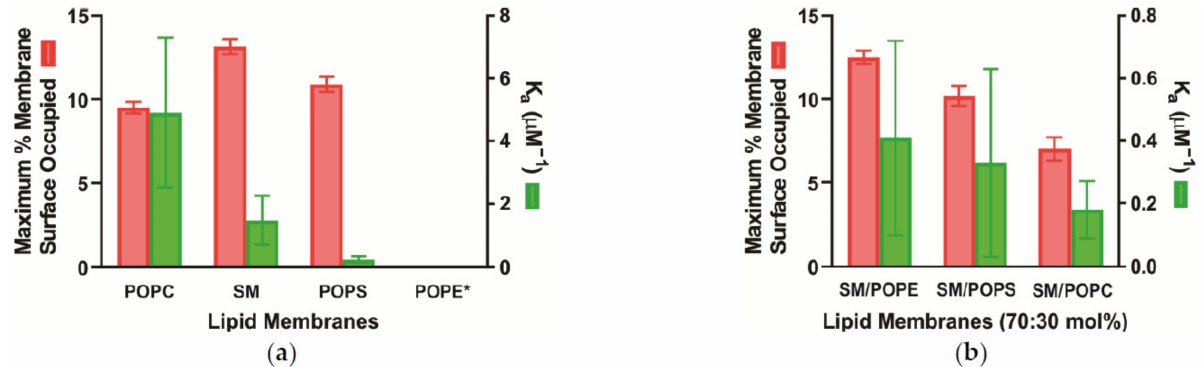
Figure 2. The maximum percentage of membrane surface occupied (MMSO) by α -crystallin and the binding affinity (K a ) of α -crystallin binding to the lipid (PL and sphingolipid) membranes. ( a ) Individual lipid membranes, i.e., POPC, SM, POPS, and POPE* (where * represents the presence of 30 mol% POPC); ( b ) Two-component lipid membranes, i.e., SM/POPE, SM/POPS, and SM/POPC in 70:30 mol%. Redrawn with permission from [99,101], Copyright 2021, with permission from Taylor & Francis and